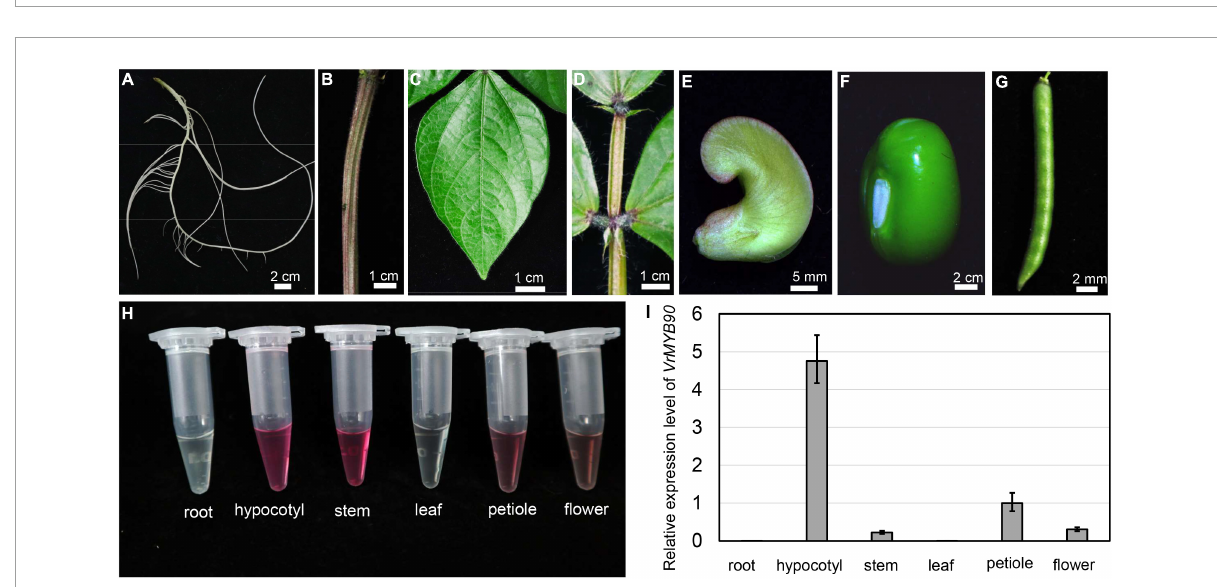
FIGURE6 Expression patterns of VrMYB90 in different tissues/parts of mungbean. (A–G) Color observation of root (A) , stem (B) , leaf (C) , petiole (D) , mature flower (E) , young seed (F) , and young pod (G) of mungbean cultivar Guilv1. (H) Fresh extracts from different tissues of Guilv1. (I) The expression level of VrMYB90 from different tissues/parts of Guilv1. The expression of VrMYB90 in petiole was set as